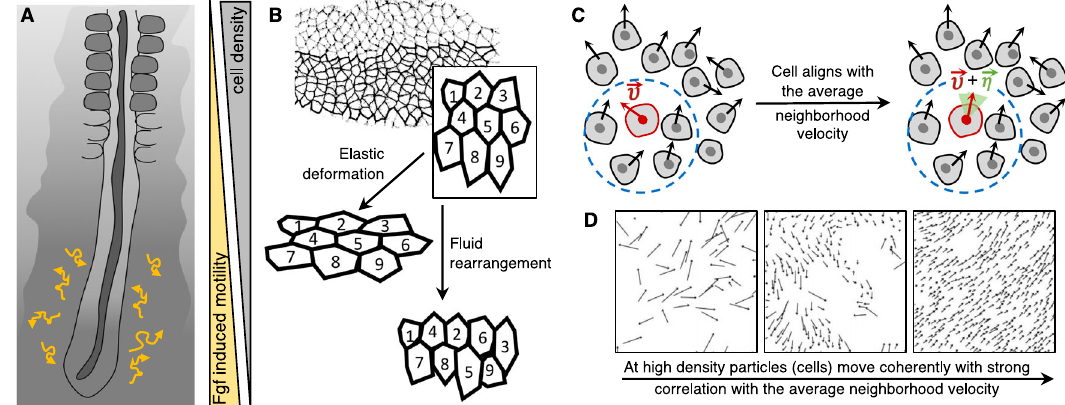
Fig. 3 Phase transitions resulting from changes in cellular motility. A In chick presomitic mesoderm (PSM), mesenchymal cells display Brownian motion relative to the underlying extracellular matrix, such that the overall tissue has a fl uid-like behavior. They undergo gradual “ solidi fi cation ” as they move from posterior to anterior under the in fl uence of Fgf (adapted from ref. 21 with permission from Nature ). B Active cellular rearrangements, due to myosin- dependent junction remodeling, during germband elongation of the Drosophila embryo render the tissue fl uid-like due to neighbor exchanges (adapted from ref. 112 with permission from Nature Cell Biology ). On the contrary, an elastic deformation keeps the same con fi guration between neighbors. C , D Kinetic phase transition of motile cells marks the emergence of self-ordered motion in systems of self-propelled particles. Within a collection of motile cells, each ! ! cell can change its direction of motion ( ν ), with some perturbation ( η denoted by green shade) depending upon the average direction of motion in its neighborhood (denoted by blue circle). This leads to progressively increasing correlation of velocities as a function of density and noise the particles move with, resulting in a novel phase transition from no transport to fi nite net transport through spontaneous symmetry breaking of the rotational symmetry (adapted from refs. 31,33 with permission from Physical Review Letters and Physical Review E